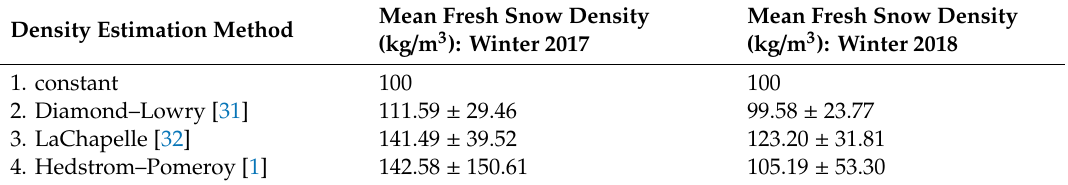
Table 1. Mean snow density estimates for the left tree in both winter sampling periods utilizing each of the density estimation Equations (1)–(4)